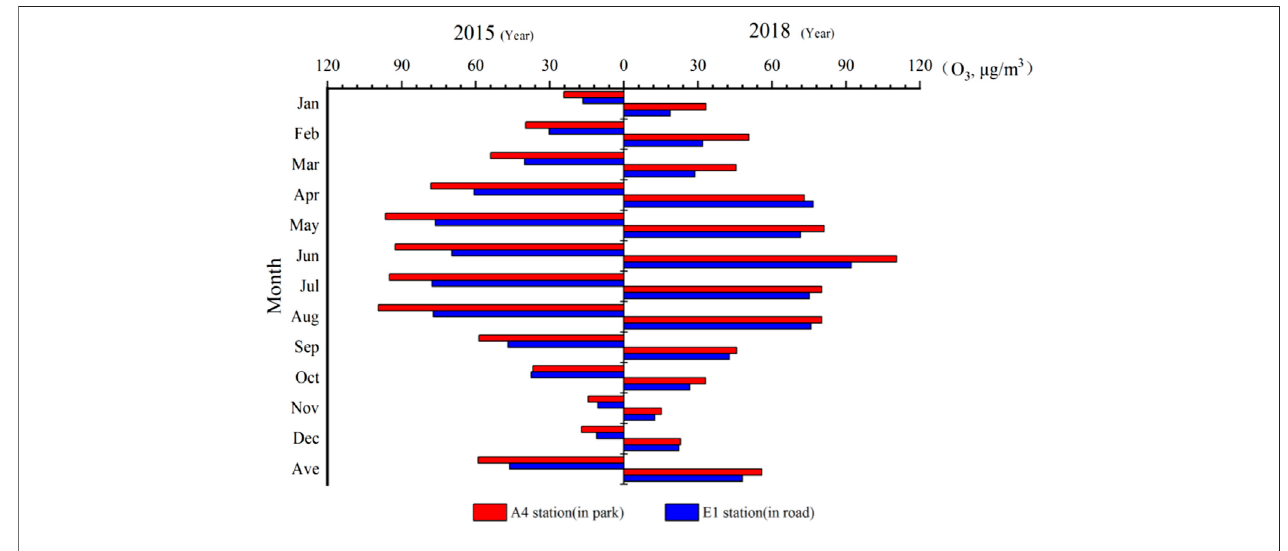
FIGURE 7 | Comparison of O 3 concentrations between A4 and E1 station.